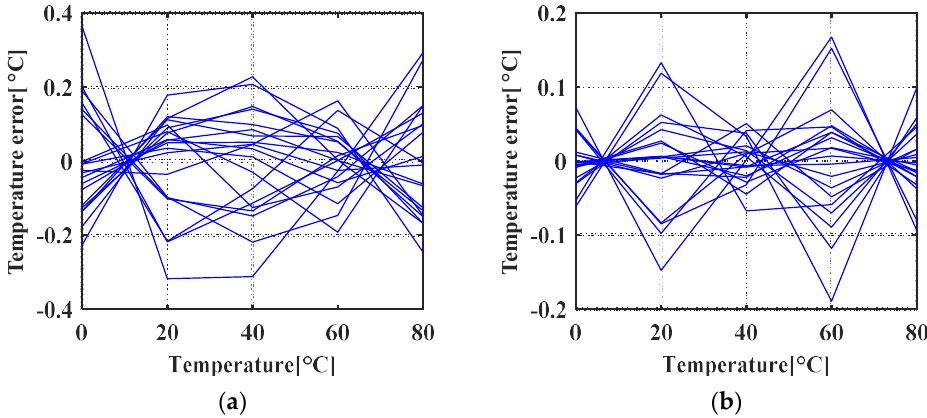
Figure 12. Simulated temperature error ( a ) after 1 st order polyfit and systematic nonlinearity removal ( b ) after 2 nd order polyfit and systematic nonlinearity removal.